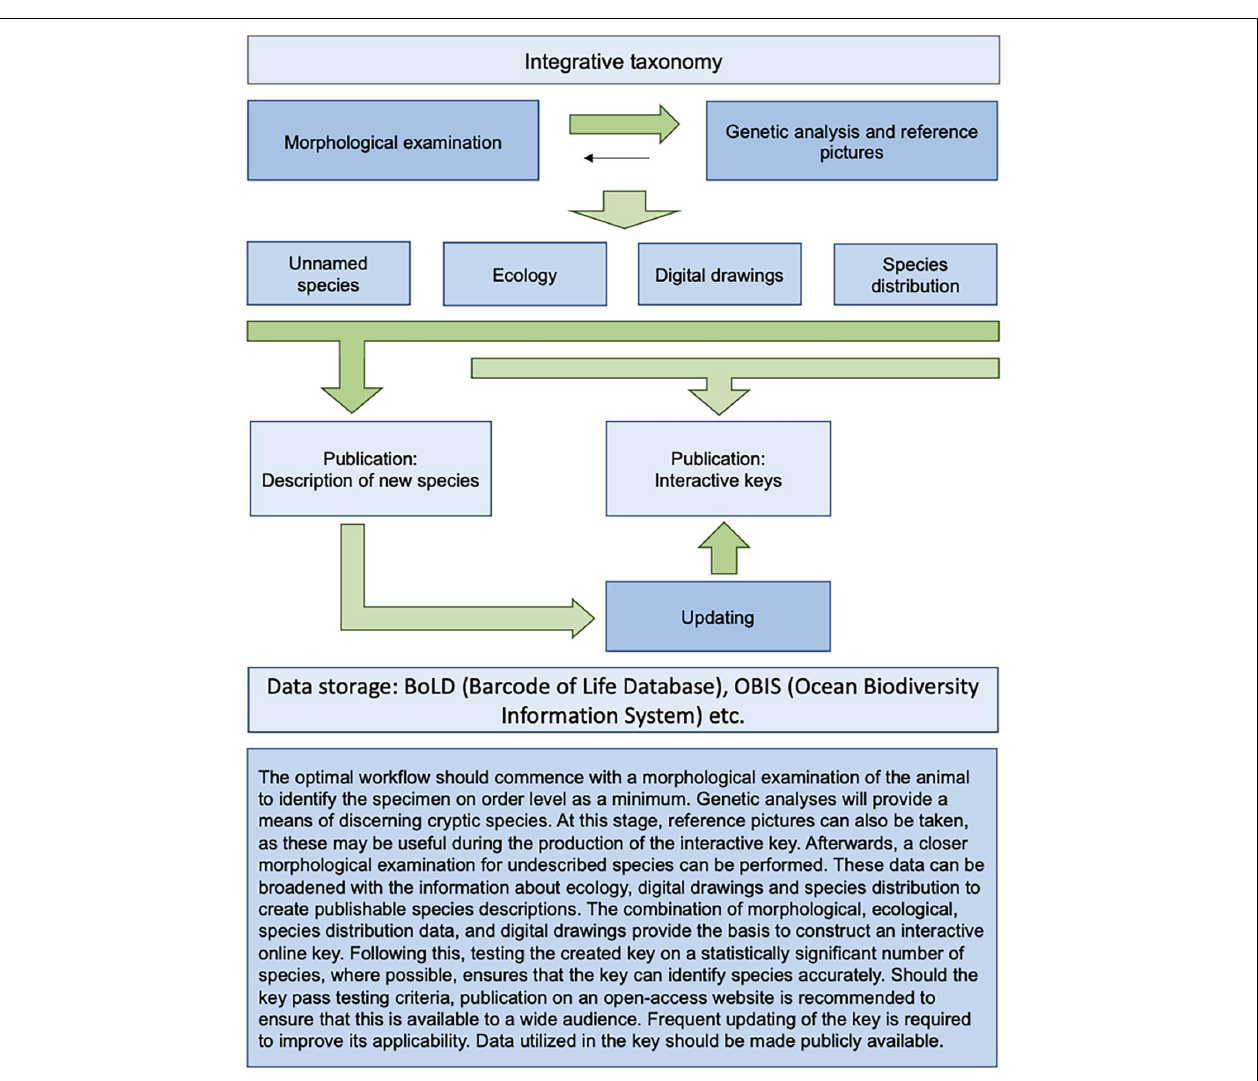
FIGURE 12 | Ideal workflow for interactive keys and integrated